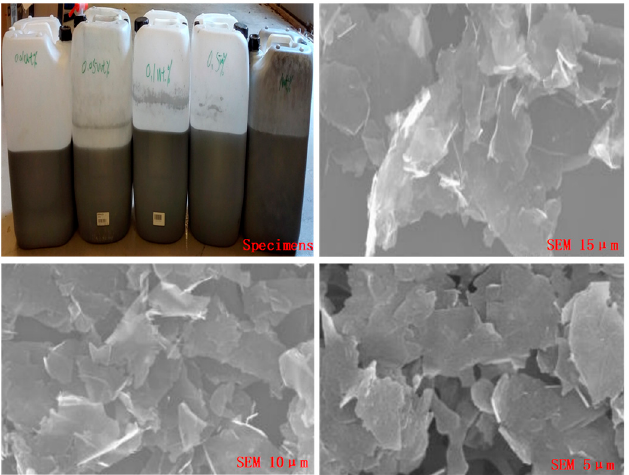
Figure 2. Nanofluids samples views of the experiment and SEM image of GnP.